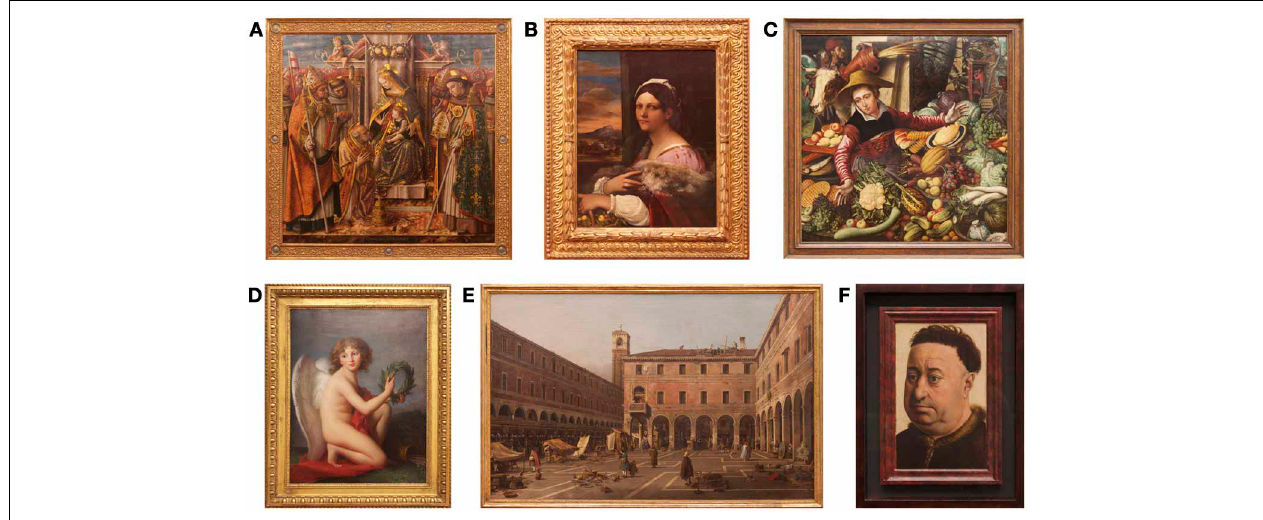
FIGURE 2 | Examples of the framed paintings (PwF images) analyzed. All paintings are from the Painting Gallery [ (A) Carlo Crivelli, 1488/89; (B) Sebastiano Luciani, 1513; (C) Pieter Aertsen, 1567; (D) Élisabeth-Louise Vigée-Lebrun, 1789; (E) Canaletto,